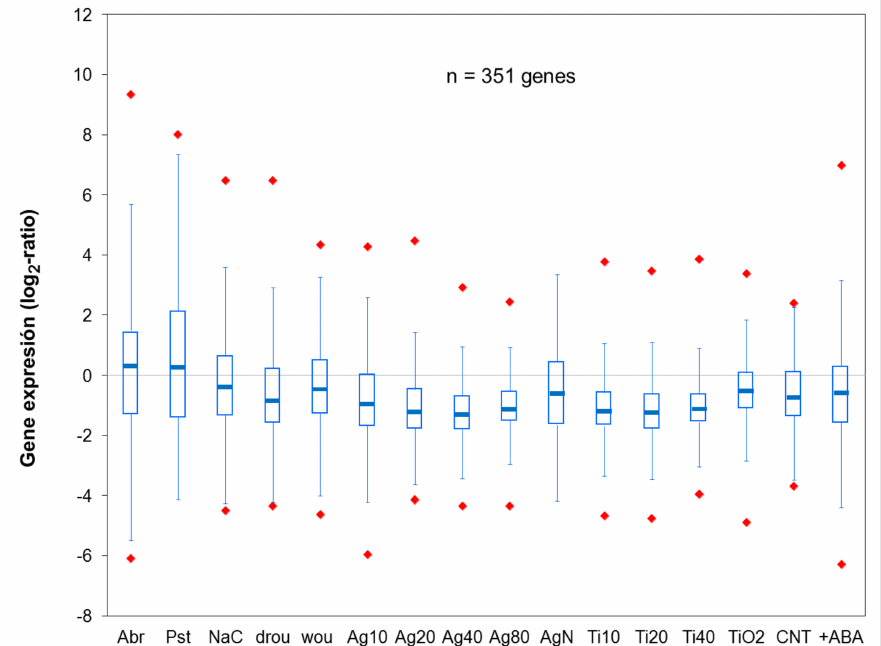
Figure 4. Box-plot representation of expression ratios for 351 NP-responsive genes [34]. Quartile distribution of the expression ratios for the gene set is shown, where boxes represent Q1 and Q3 quartiles and the middle line of the box is the median (Q2), while whiskers show the minimum and maximum values and red diamonds represent outliers. ( Pst , Abr ) biotic stresses by bacteria or fungi, ( drou , NaC , wou ) abiotic stresses by drought, salt or wounding, ( Ag20 , Ag40 , Ag80 , AgN ) addition of Ag NPs (10-, 20-, 40- and 80-nm diameter) or AgNO 3 , ( Ti10 , Ti20 , Ti40 , TiO2 ) addition of TiO 2 NPs (10-, 20-, 40-nm diameter) or bulk TiO 2 , ( CNT , +ABA ) addition of CNTs or CNTs plus ABA. Notice that most genes are repressed under NP